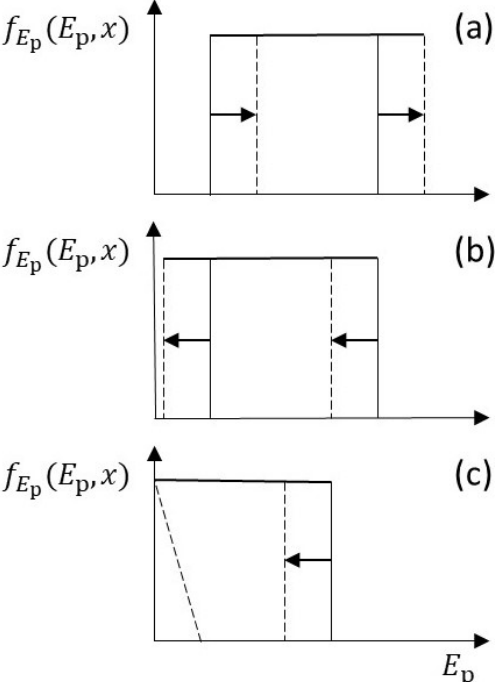
Figure 3. Schematic diagram of downslope changes in the distri- bution f E ( E p ,x ) of particle energy states E p (for simplicity a uni- p form distribution) due to the following: (a) gravitational advective heating in the absence of cooling; (b) advective frictional cooling in the absence of heating; and (c) net cooling. Arrows represent displacement occurring over a small downslope interval d x . The triangle represents an idealized situation in which, with net cool- ing, the likelihood of deposition increases with decreasing particle energy E p and decreases with increasing energy. Note that an ef- fect of deposition with heating or cooling is to increase the aver- age energy (cid:104) E p (cid:105) by culling lower-energy particles, thereby select- ing higher-energy particles for continued travel with increasing dis-